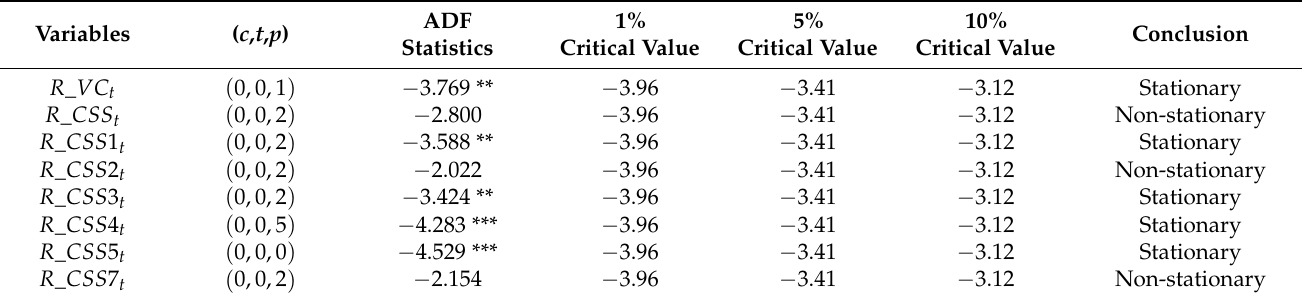
Table A4. Results of the unit root test for residuals.